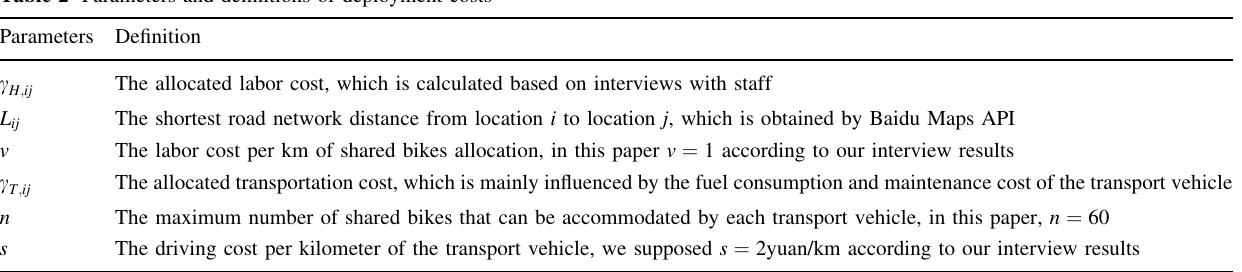
Table 2 Parameters and definitions of deployment costs Parameters